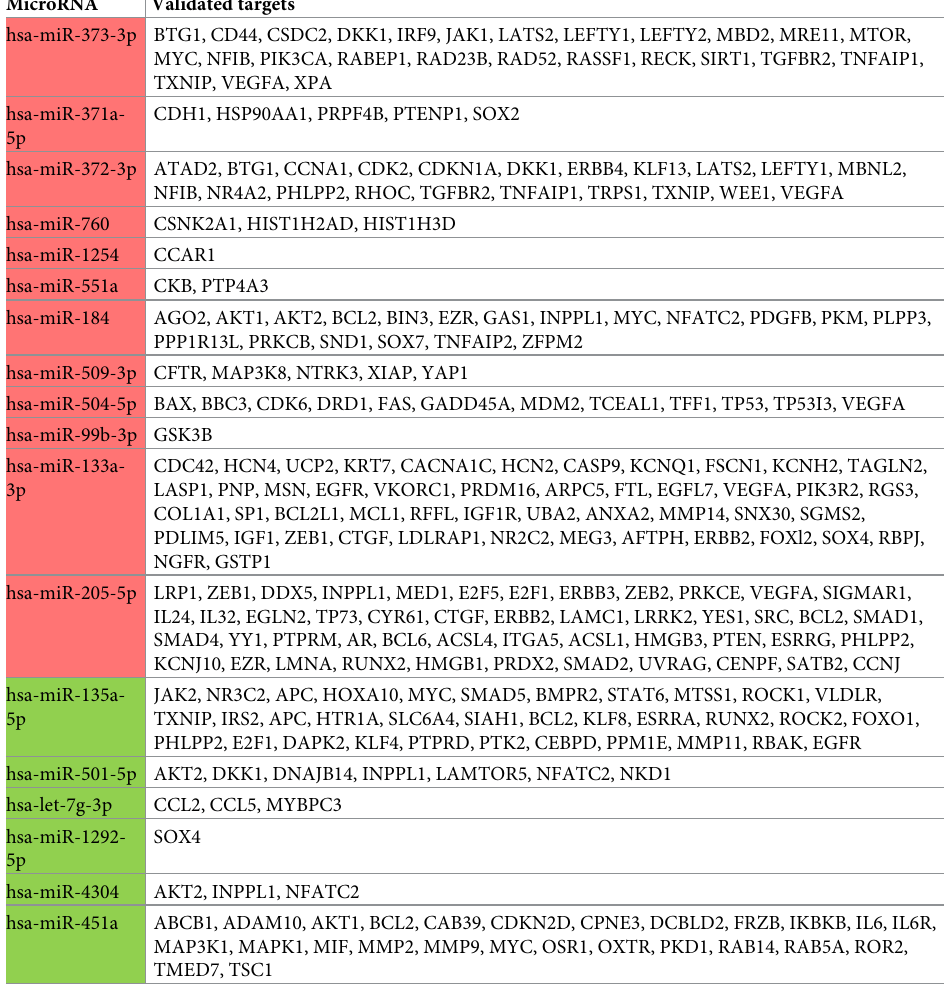
Table 2. Human placental miRNAs and their experimentally validated targets. MiRNAs that were either up- (red) or down- (green) regulated at the onset of labor and have validated targets are shown. Listed miRNA targets were obtained with miRTarBase software. All miRNA–target interactions have been validated by reporter assay, western blot, and/or qPCR. miRNAs are in the same order as listed in Table